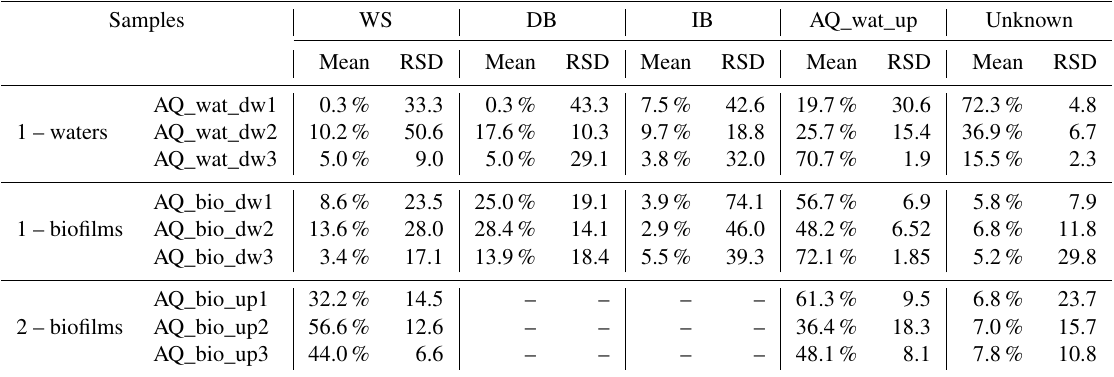
Table 1. Coalescence of surface and aquifer bacterial communities inferred by the SourceTracker Bayesian approach and the 16S rRNA gene metabarcoding dataset ∗ .